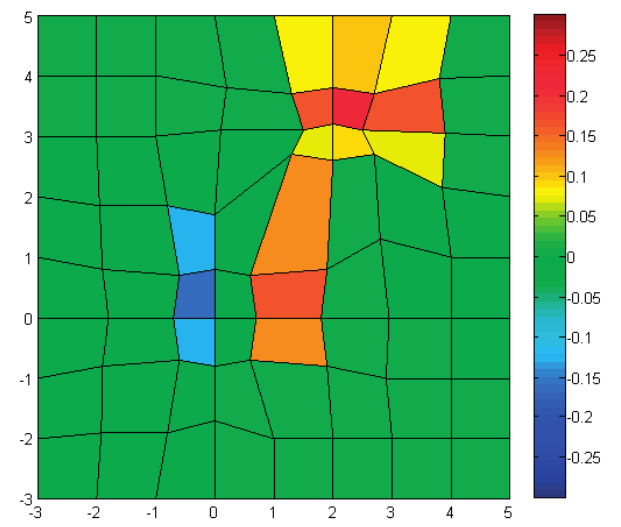
Figure 12. Measured model (reconfigured): 2D plot with color